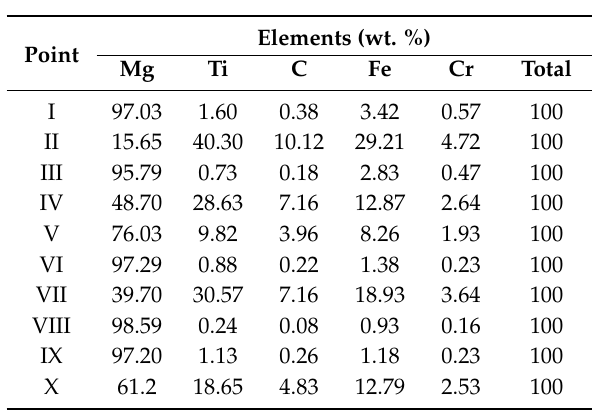
Table 1. Local EDS elemental analysis of the points presented in Figure 2a for MgH 2 /5.2TiC/4.6FeCr nanocomposite powders obtained after 50 h of ball milling. The oxygen content introduced to the sample during TEM sample preparations is not